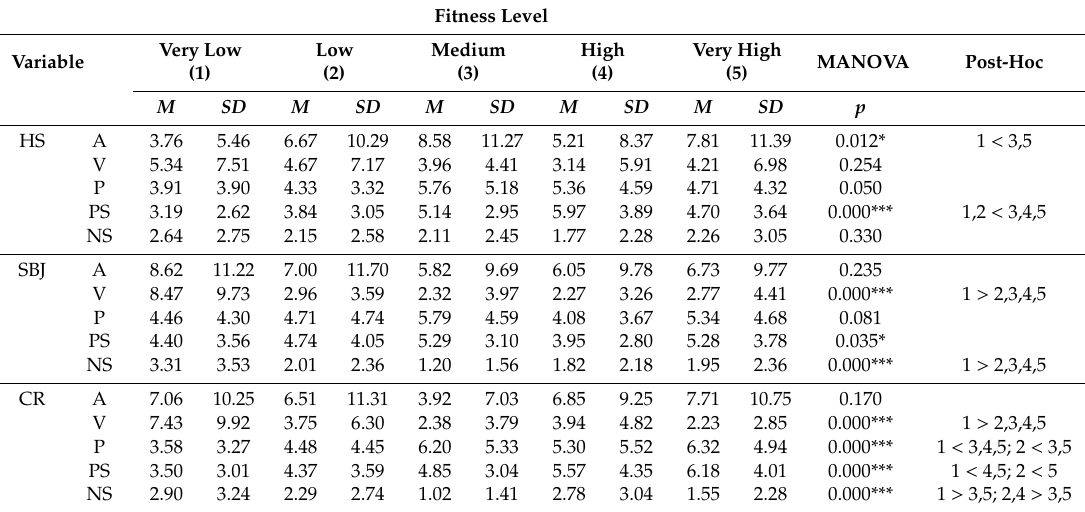
Table 3. Average scores in the nominations according to the PF and its level. MANOVA and post-hoc. Fitness Level Variable